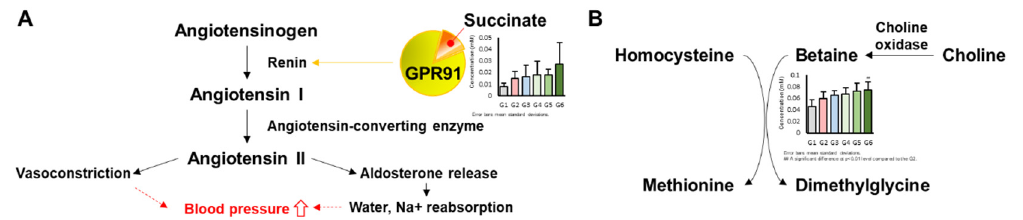
Figure 6. Metabolites that affect regulation of blood pressure. ( A ) Regulation of renin-angiotensin- aldosterone system (RAAS) by succinate and GPR91. ( B ) Methyl donation of betaine to homocysteine.